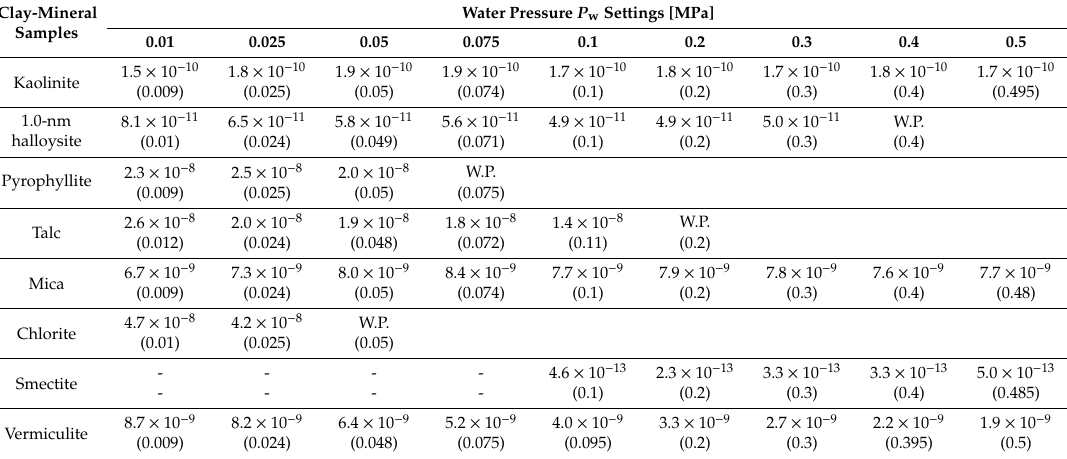
Table 3. Hydraulic conductivities [m / s] of clay mineral samples under di ff erent water pressure conditions (void ratio = 0.95). The values within parentheses in the table refer to the actual water pressure [MPa] measured, and W.P. indicates the observed water path in the